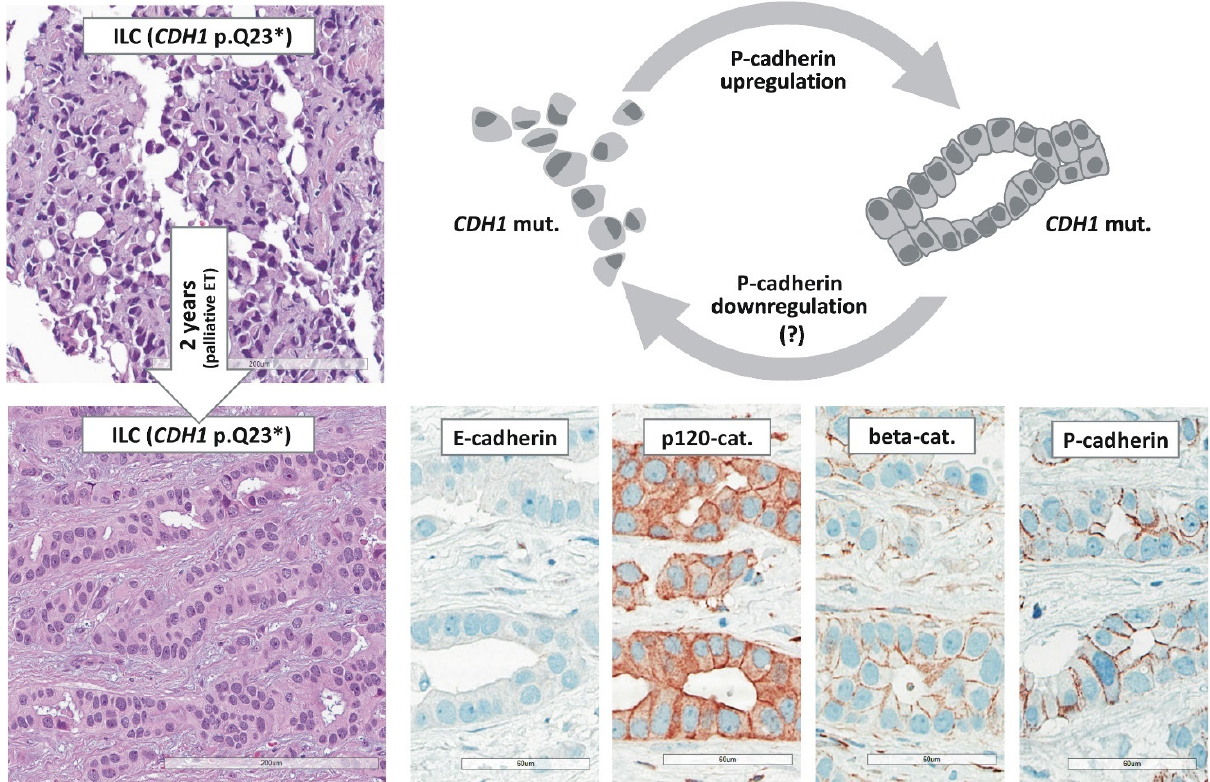
Figure 5. E-cadherin to P-cadherin switching in ILC with tubular elements [59]. Photomicrographs (×200 magnification) illustrate an ILC diagnosed by CNB (upper left) and the resection specimen after primary endocrine therapy (ET). Both specimens were E-cadherin-negative and harbored the same deleterious CDH1 mutation (p.Q23*). Note that the resection specimens displayed tubular elements which were associated with expression of P-cadherin and β -catenin, while p120- catenin showed a partially aberrant cytoplasmic localization and a partially regular membranous localization. The cartoon illustrates that ILC cells form focal tubular elements by dynamic upregulation of P-cadherin (id est, E-cadherin to P-cadherin switching) [59].